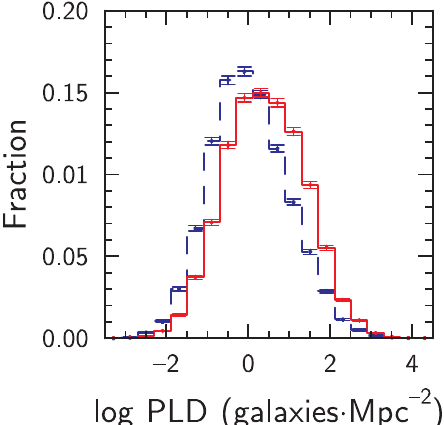
Fig. 2. Local density distribution for the pair and the control samples. Designations are the same as in Figure 1. SSFR from “The MPA-JHU DR7 release of spectrum measurements” 2 . The